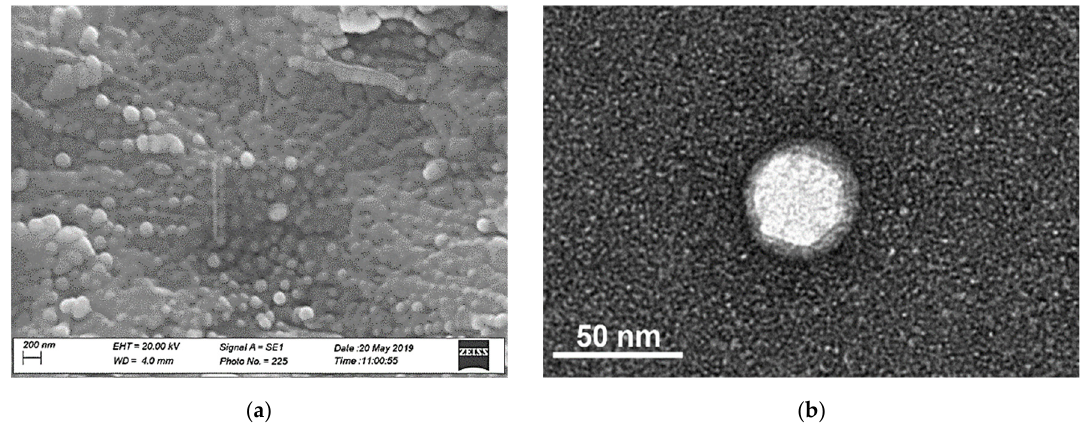
Figure 1. ( a ): SEM morphology of dried dispersion M7-300-TP-MTR; bar = 200 nm. ( b ): TEM image of single NLC from M7-300-TP-MTR batch; bar = 50